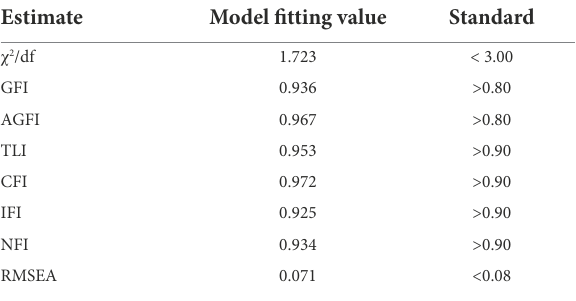
TABLE 5 Fitting index of the relationship model between SIS, AODS. and OAI-20. Estimate